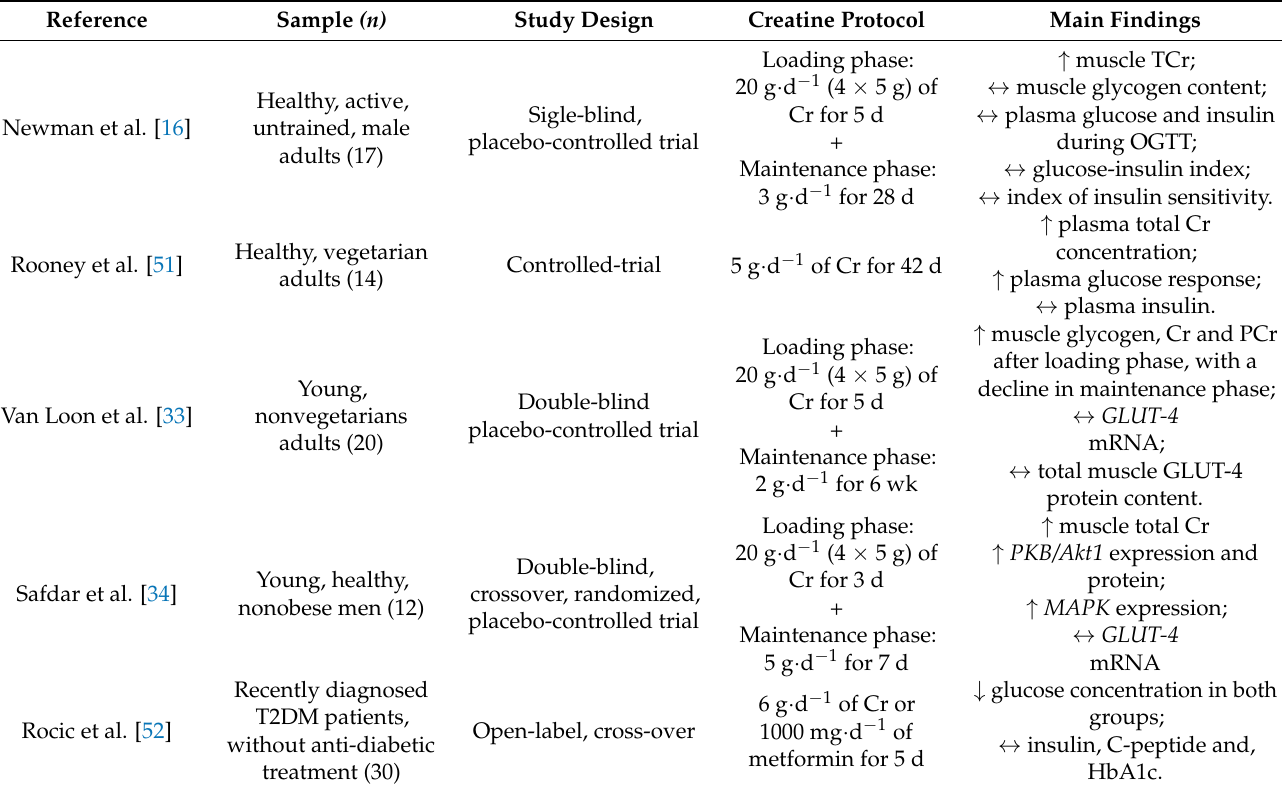
Table 2. Effect of creatine supplementation alone in glucose metabolism in